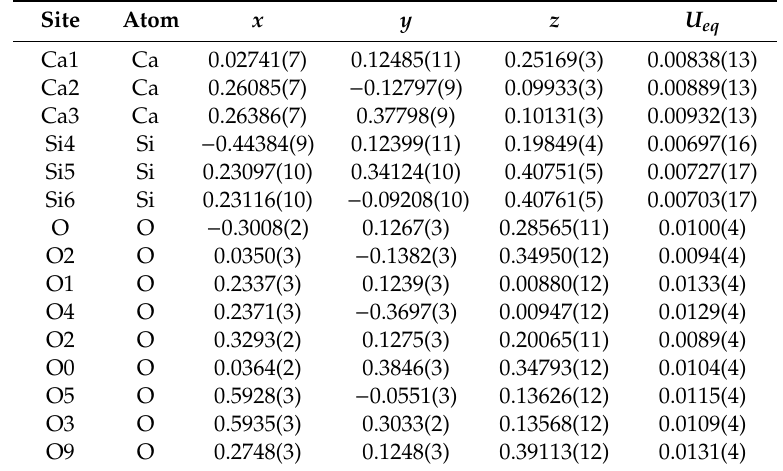
Table 8. Atomic coordinates and isotropic equivalents ( U eq ) in Å 2 for wollastonite (CE 5B).